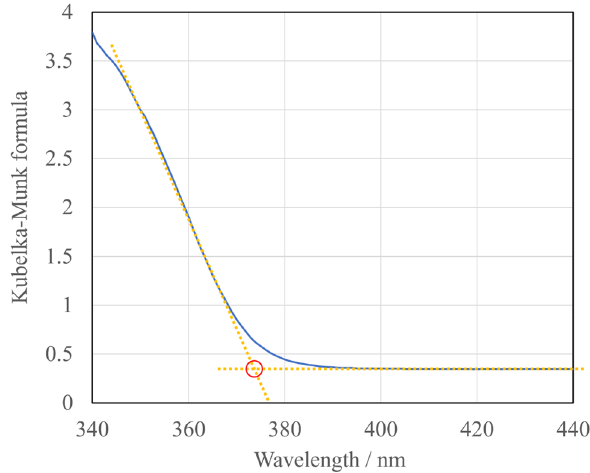
Fig. 11 Bandgap determination by fitting the Kubelka–Munk con- version curve spectra of the AuNP/TiO